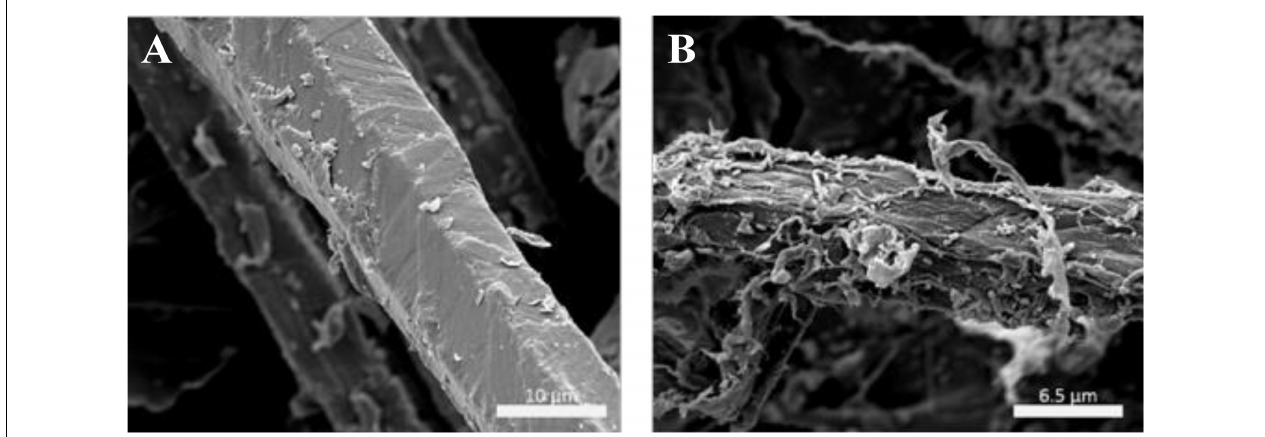
FIGURE 2 | SEM image for raw (A) and F 2 O pretreated (B)